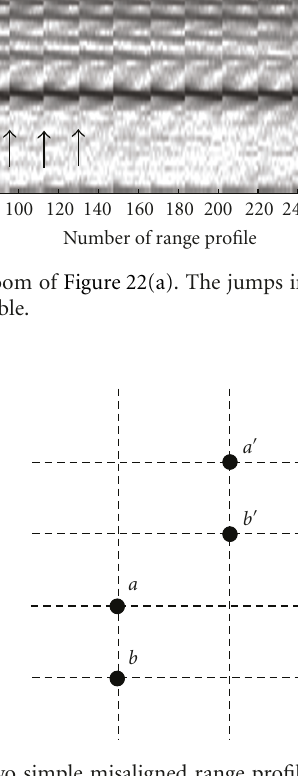
Figure 24: Two simple misaligned range profiles with little target